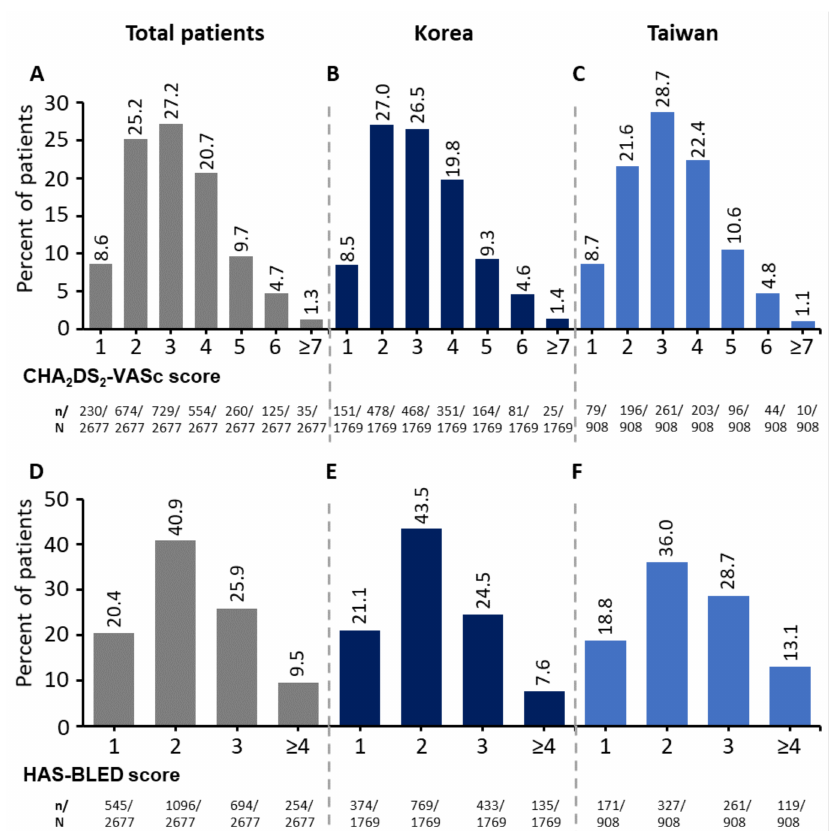
Figure 1. Distribution of CHA 2 DS 2 -VASc and HAS-BLED Scores. Distribution of CHA 2 DS 2 -VASc ( A – C ) and HAS-BLED ( D – F ) scores for total patients ( A , D ), patients from Korea ( B , E ) and patients from Taiwan ( C , F ). A total of 70 patients (2.6%) had a CHA 2 DS 2 -VASc score of 0; 88 patients (3.3%) had a HAS-BLED score of 0. CHA 2 DS 2 -VASc, congestive heart failure, hypertension, age, diabetes, prior stroke/TIA, vascular disease, and sex category; HAS-BLED, hypertension, abnormal renal and liver function, stroke, bleeding history or disposition, Labile INR, elderly, drugs or alcohol; INR, international normalized ratio; TIA, transient ischemic